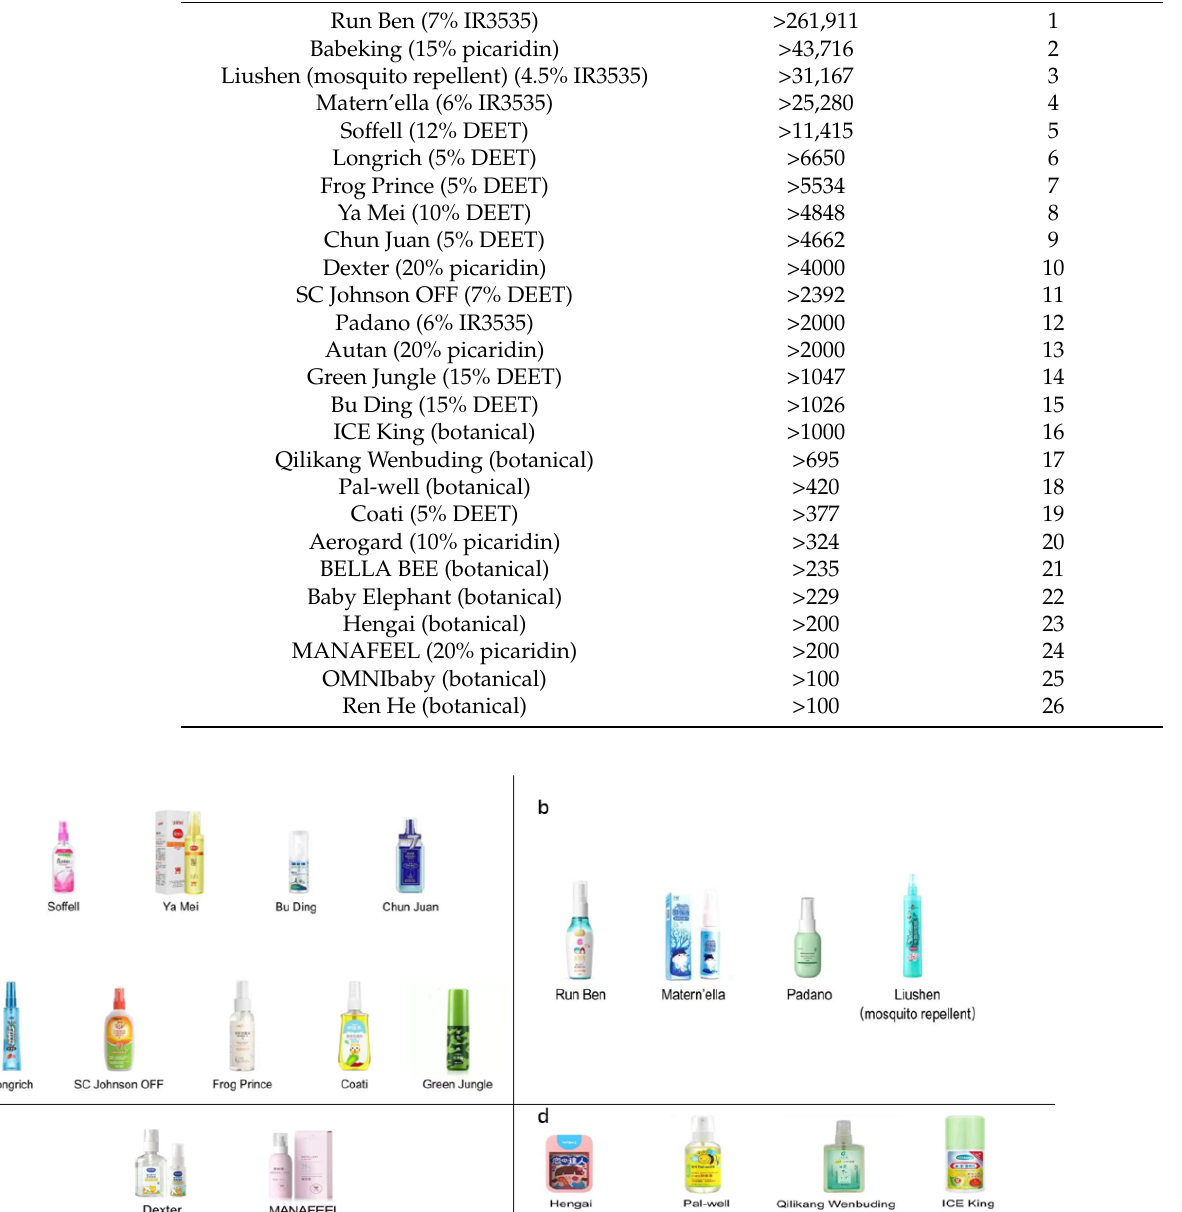
Table 1. Sales of various mosquito repellent products on e-commerce platforms Taobao and Jing- dong in July.